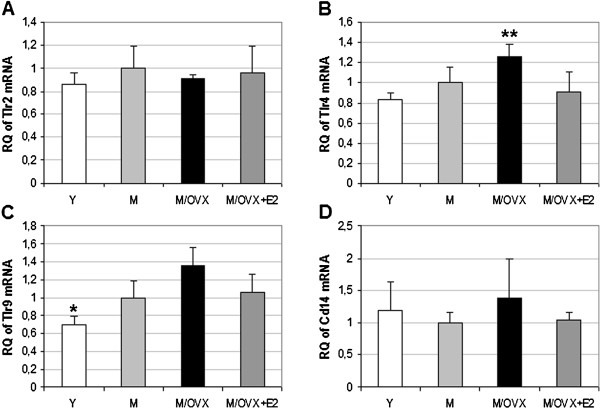
Age- and ovarian hormone-dependent regulation of genes encoding toll-like receptors and co-receptor Cd14 in the rat frontal cortex. TaqMan-based quantitative real-time PCR revealed changes in mRNA expression of Tlr4 (B) and Tlr9 (C). Tlr2 (A) and Cd14 (D) did not alter. Error bars show SD of six independent measurements. Statistical significance of the alterations in different groups compared to middle-aged female rats (M) was calculated using analysis of variance (ANOVA) with Newman-Keuls post hoc test, and considered significant at P < 0.05. Asterisks indicate changes with statistical significance: * corresponds to 0.01<P < 0.05, ** to 0.001<P < 0.01 and *** to P < 0.001. Y, young rat; M/OVX, middle-aged ovariectomized (OVX) rat; M/OVX+E2, middle-aged OVX rat treated with 17β-estradiol (E2).